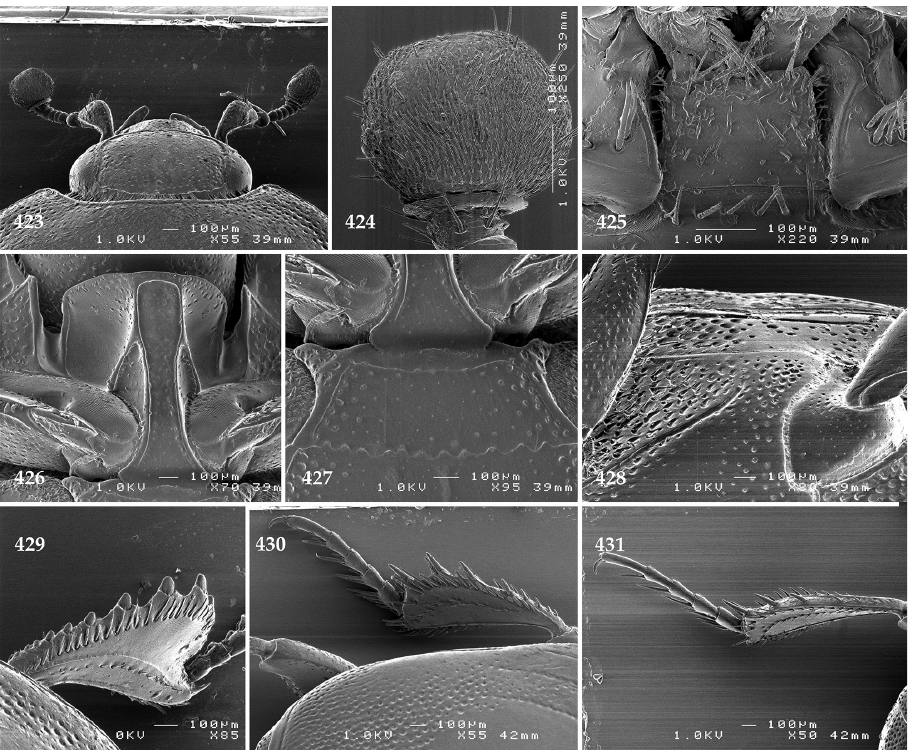
Figures 423–431. 423 Saprinus ( Saprinus ) detritus (Fabricius, 1775) head, dorsal view 424 antennal club, dorsal view 425 mentum, ventral view 426 prosternum 427 mesoventrite 428 lateral disc of metaventrite + metepisternum 429 protibia, dorsal view 430 mesotibia, dorsal view 431 metatibia, dorsal view. Clypeus rectangular, slightly depressed medially, coarsely and densely punctate; su- praorbital stria complete, slightly carinate; frontal stria weakened and interrupted medi- ally (occasionally complete); frontal disc (Fig. 423) with coarse and dense punctation, slightly finer than that of clypeus, interspaces imbricate; eyes convex, visible from above. Pronotal sides (Fig. 422) gradually narrowing anteriorly, on apical third strongly narrowed, apical angles prominent, pronotal depressions weakly impressed, anterior incision for head rather deep; marginal pronotal stria well impressed, carinate later- ally, weakened anteriorly, visible along its entire length from dorsal view; pronotal disc laterally with depressed, coarsely and densely punctate band originating approximately near pronotal depressions, not reaching apical angles; between it and lateral pronotal margin an impunctate band present. Along basal margin of pronotum a double to triple row of variously sized punctures present, weakened before ante-scutellar area; rest of pronotal disc glabrous or only with scattered microscopic punctation. Pronotal hypomeron with scattered microscopic setae; scutellum small, visible. Elytral epipleura densely and coarsely punctate; marginal epipleural stria complete; marginal elytral stria well impressed, carinate, continued as weakened, but